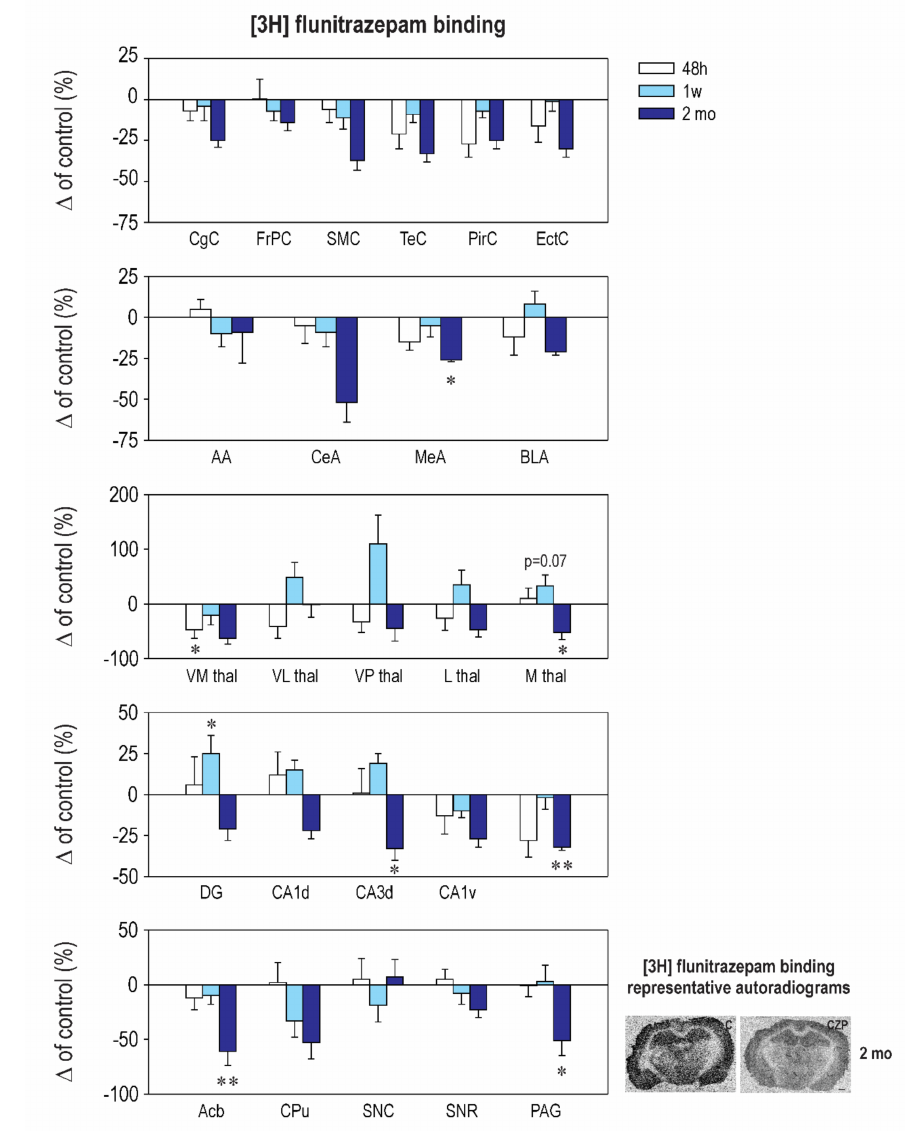
Figure 3. Relative changes in [3H] flunitrazepam binding to Benzodiazepine (BZD) receptors (means ± SEM). Panels on the right: Representative autoradiograms showing decreased binding to BZD Rp labeled with [3H] flunitrazepam. Sections were taken at the level of the hippocampus 2 months after the end of therapy. Details as in Figures 1 and 2. Asterisks denote significant di ff erences from the controls ( * p < 0.05; ** p < 0.01 ). Scale bar = 1